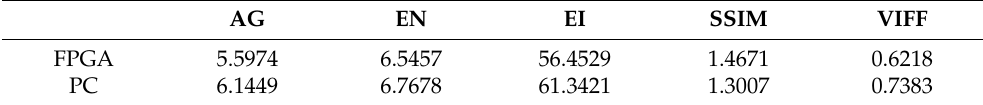
Table 5. Objective analysis for two fused images obtained on FPGA and PC.